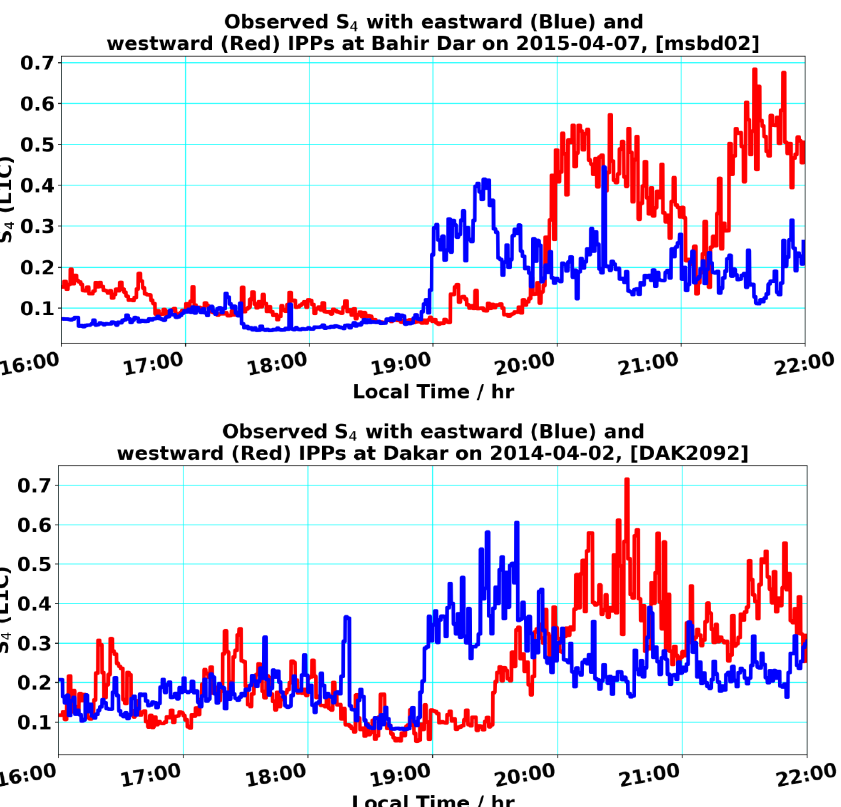
Figure 10. Local time S 4 scintillation occurrence at Bahir Dar ( upper panel ) and Dakar ( lower panel ) between 16:00 and 22:00 LT, representing separate measurements obtained eastward (blue) and westward (red) from the GNSS stations. Note that the Dakar measurement station day 92 of the year is denoted as [DAK2092] and the measurement station of Bahir Dar day 02 as